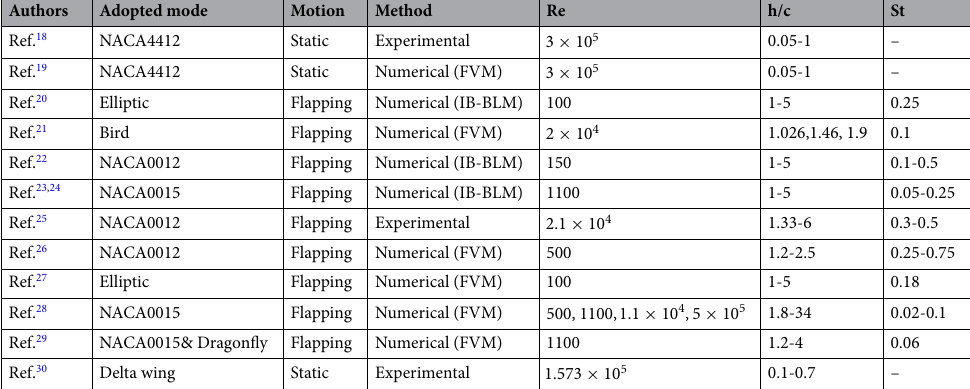
Table 1. A brief look at the noteworthy researches about the influence of ground effect on